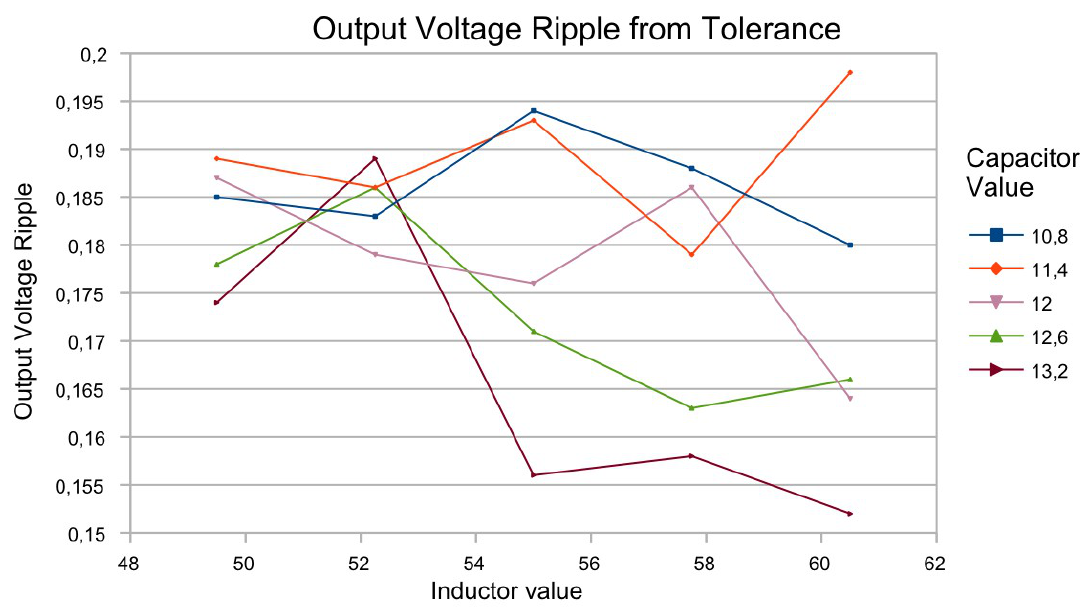
Figure 5. Tolerance analysis of the output voltage ripple.